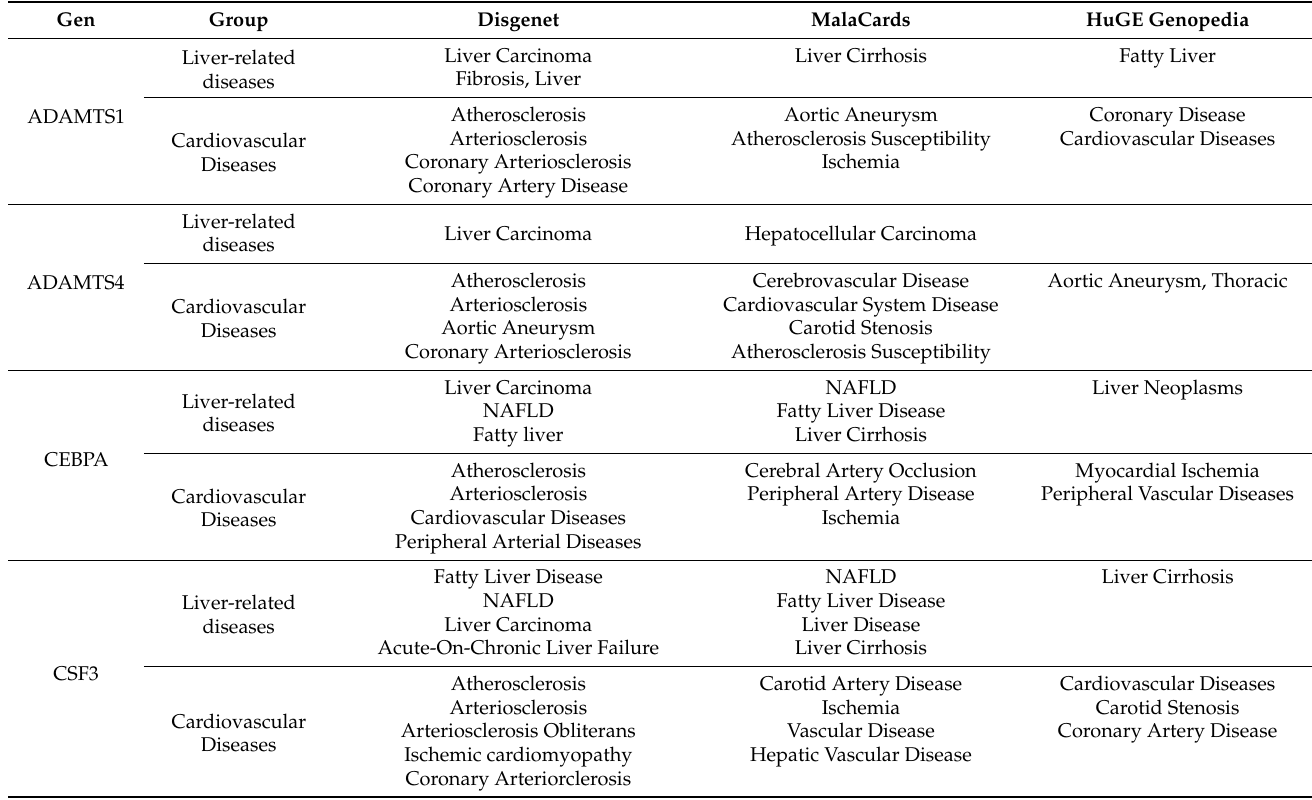
Table 3. Diseases related to genes common to ATH and NAFLD with high scores in centrality analysis or included in the functional modules of